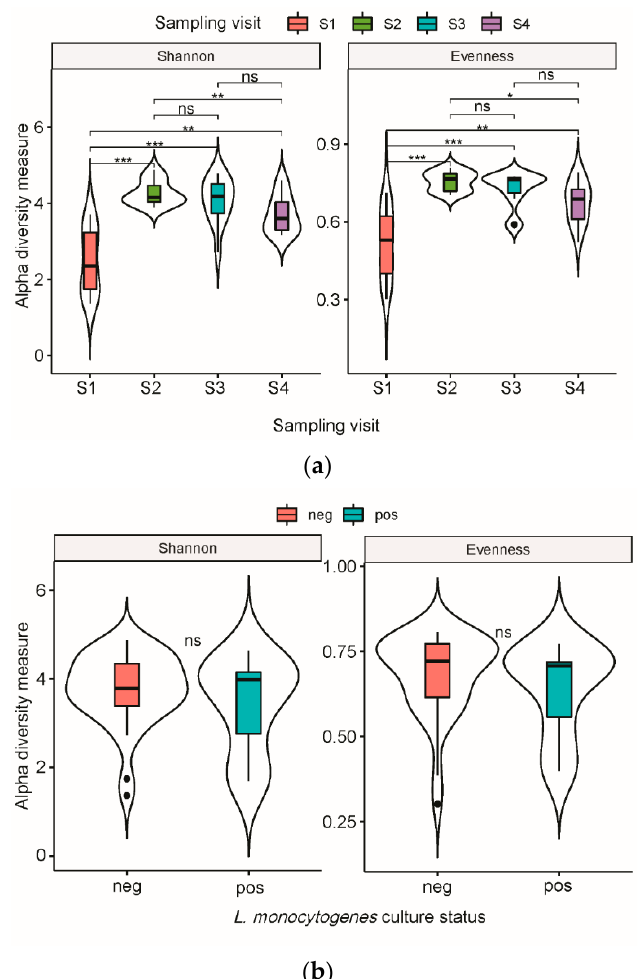
Figure 1. Violin box plot representation of alpha diversity of bacterial OTUs from meat conveyor surfaces in a cutting facility from a swine slaughterhouse. ( a ) Diversity was measured by Shannon diversity index and Shannon evenness index according to sampling visit, with medians compared using the Kruskal–Walis test. ( b ) Diversity was measured by Shannon diversity index and Shannon evenness index according to Listeria monocytogenes culture status, with medians compared using the Wilcoxon test. Statistical significance: n.s., p > 0.05 *, p < 0.05 **, p < 0.01 ***, p < 0.001.